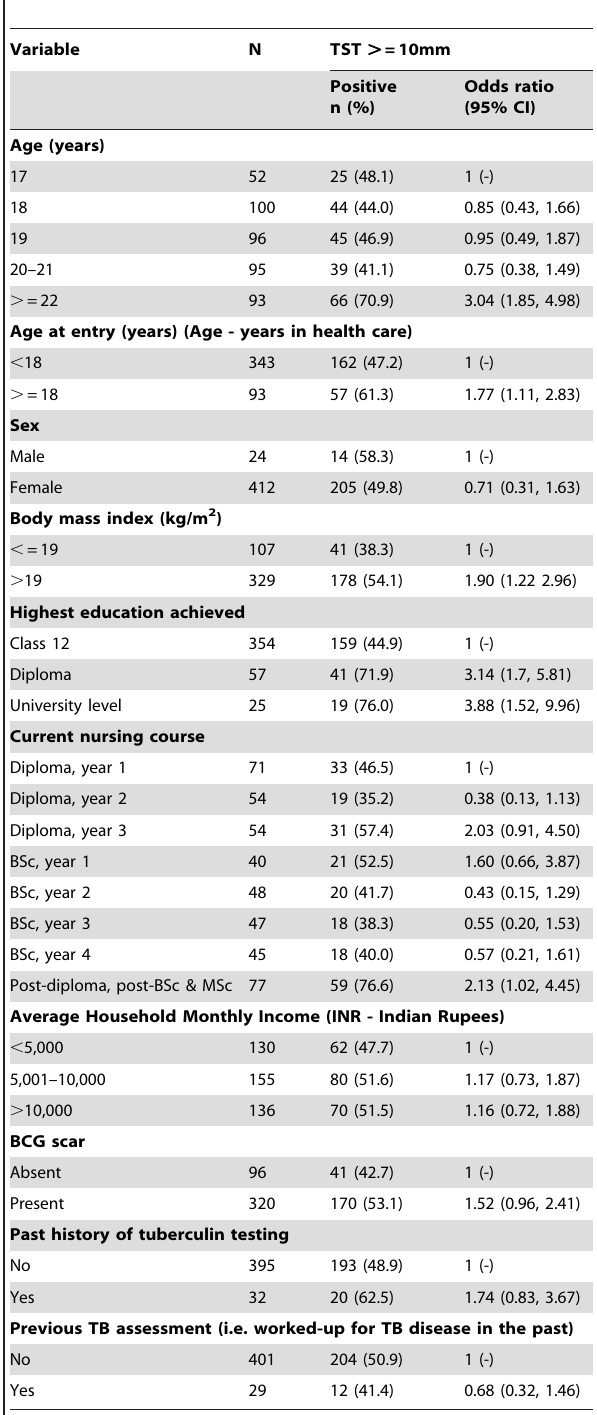
Table 4. Association between demographic variables and TST positivity: Results of univariate logistic regression.